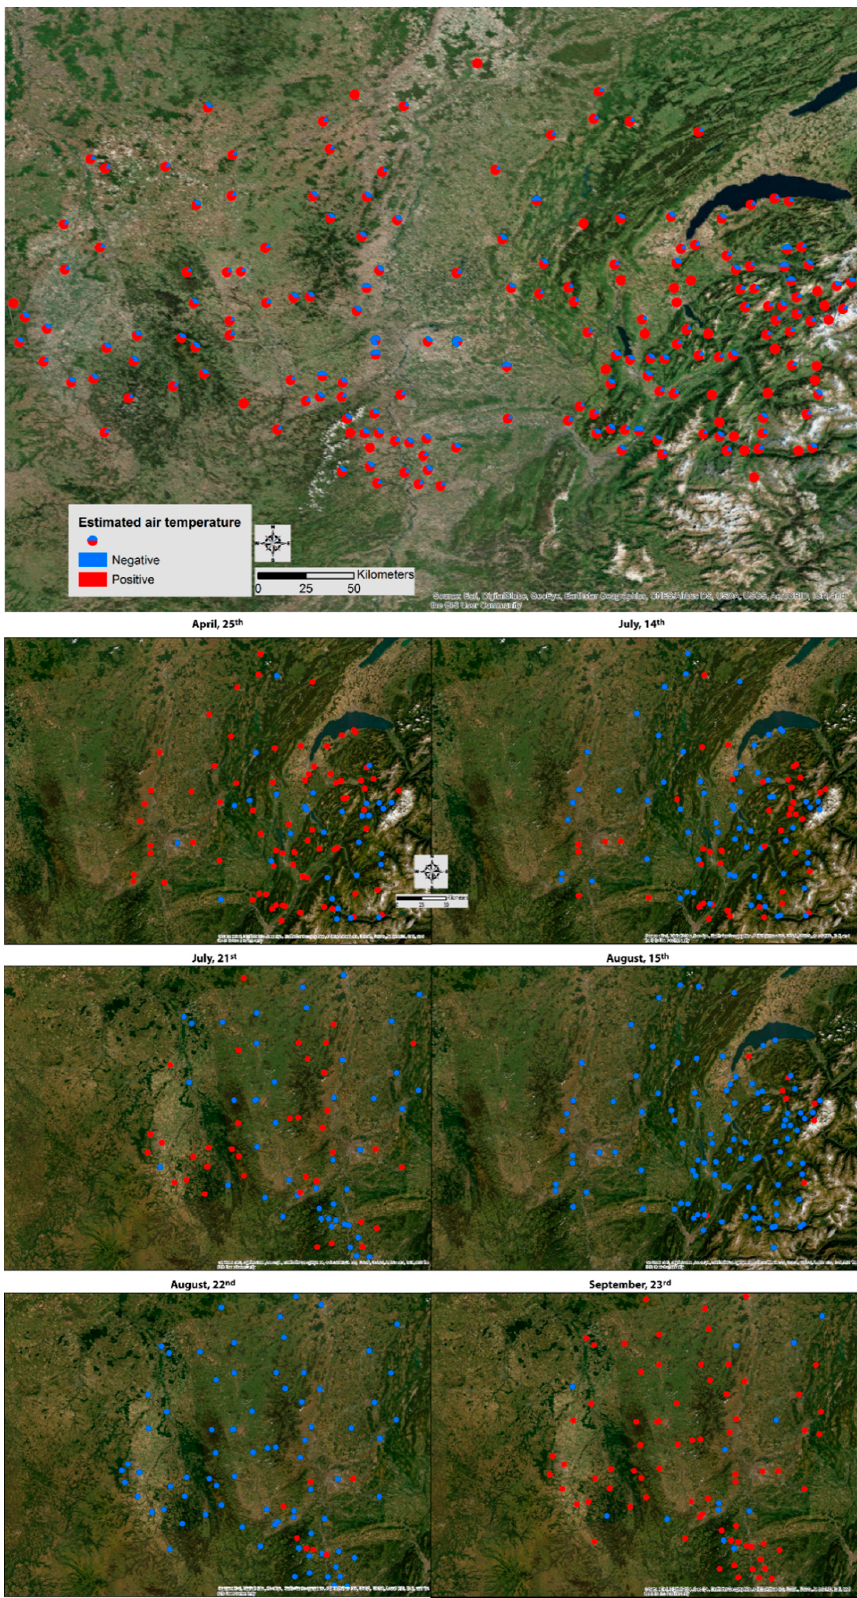
Figure 4. Pie charts of the number of times the relative error of air temperature estimation (positive or negative) for the six days studied ( top figure ) and detailed day by day ( bottom figures ).